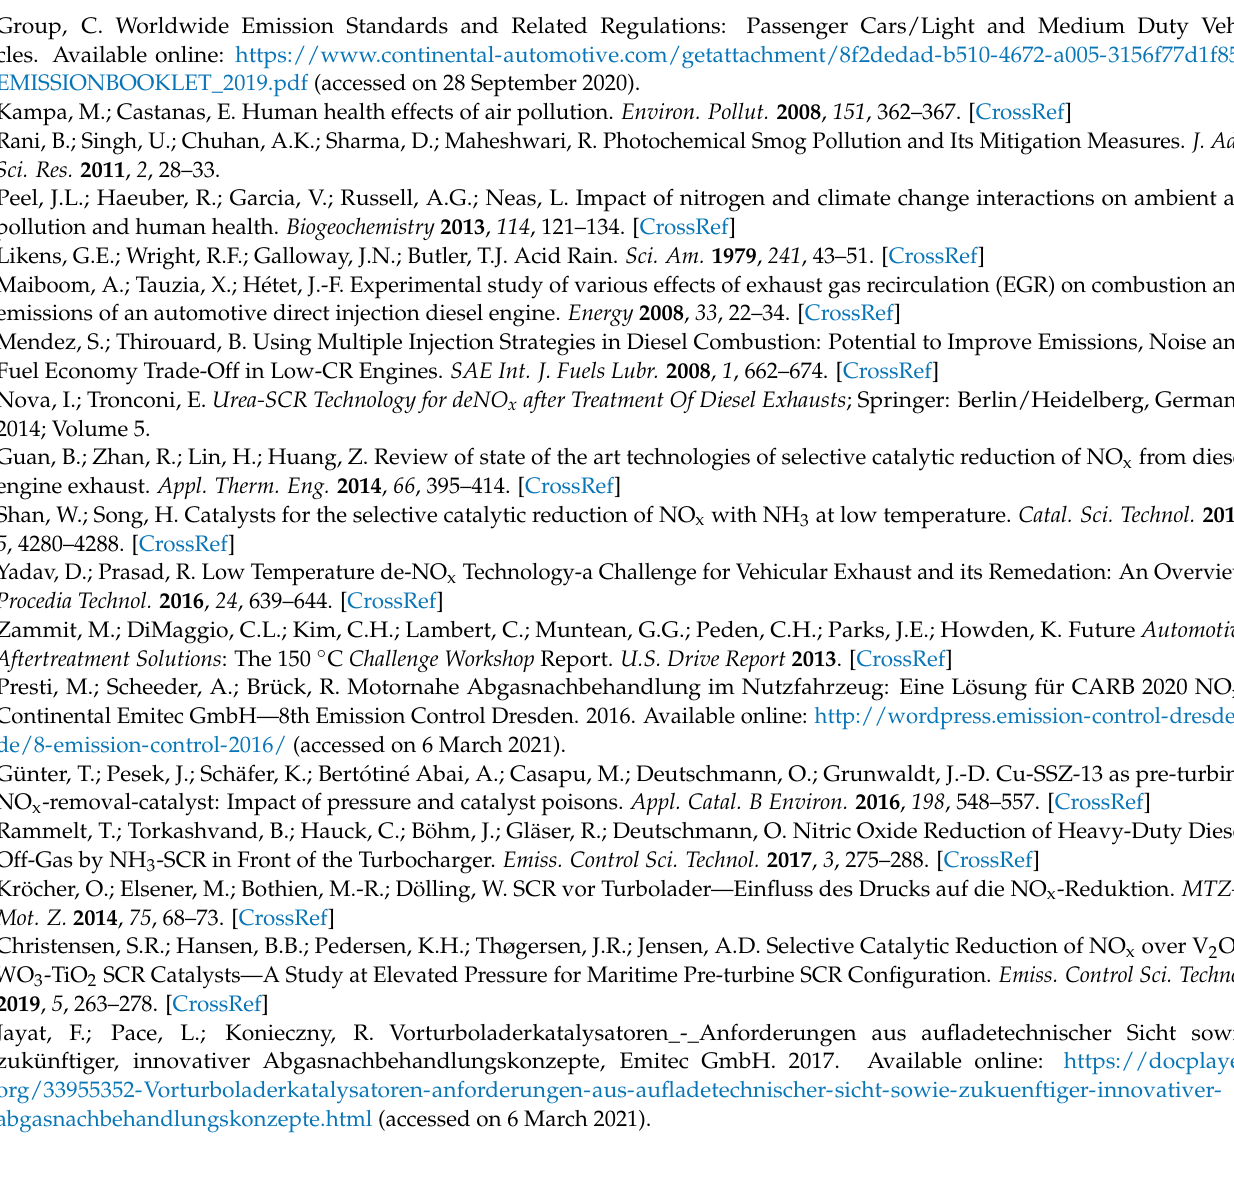
Figure S8: NO x /NH 3 /C 12 H 26 conversion and N 2 O emission over Fe-ZSM-5 for 1 bar (left) and 5 bar (right) in Standard SCR gas mixture (50 ppm C 12 H 26 , 350 ppm NO, 350 ppm NH 3 , 14% O 2 , 4.5% H 2 O in N 2 ), Table S1: Washcoat loading of Fe-ZSM-5 and Cu-SSZ-13